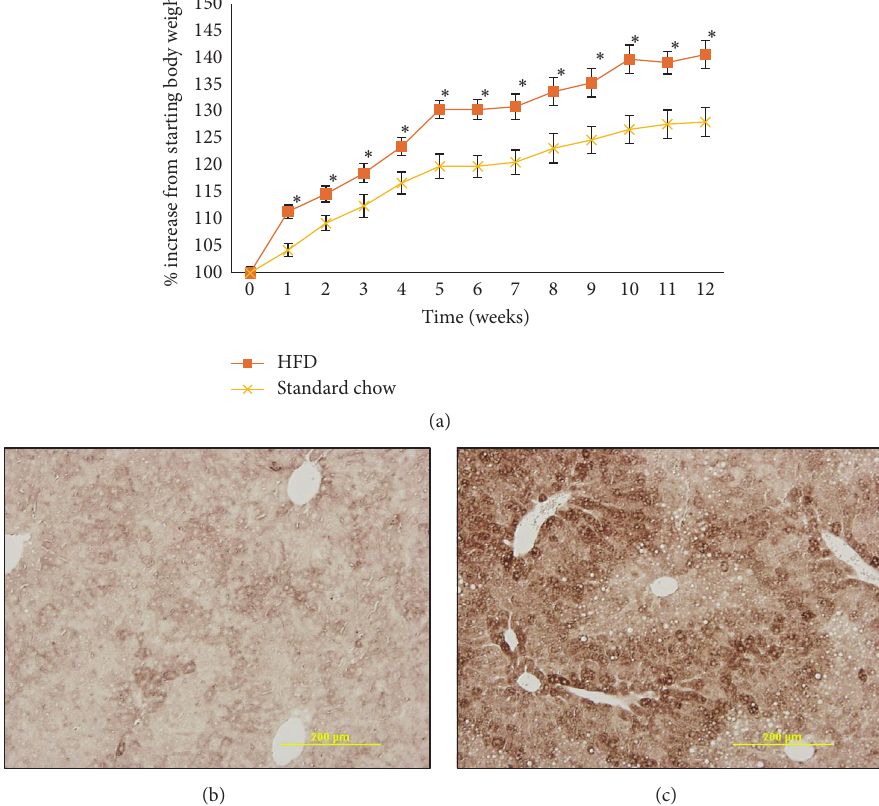
Figure 1: High fat diet induces obesity and elevates ADAM19 expression in mice. Mice fed a high fat diet gained weight (a); 𝑛 = 14 – 18 /group. Representative photomicrographs of ADAM19 protein expression in livers from mice fed either a normal chow (b) or high fat diet (c). ADAM19 staining is cytoplasmic and brown in colour. 200x magnification. ∗ 𝑝 < 0.05 .